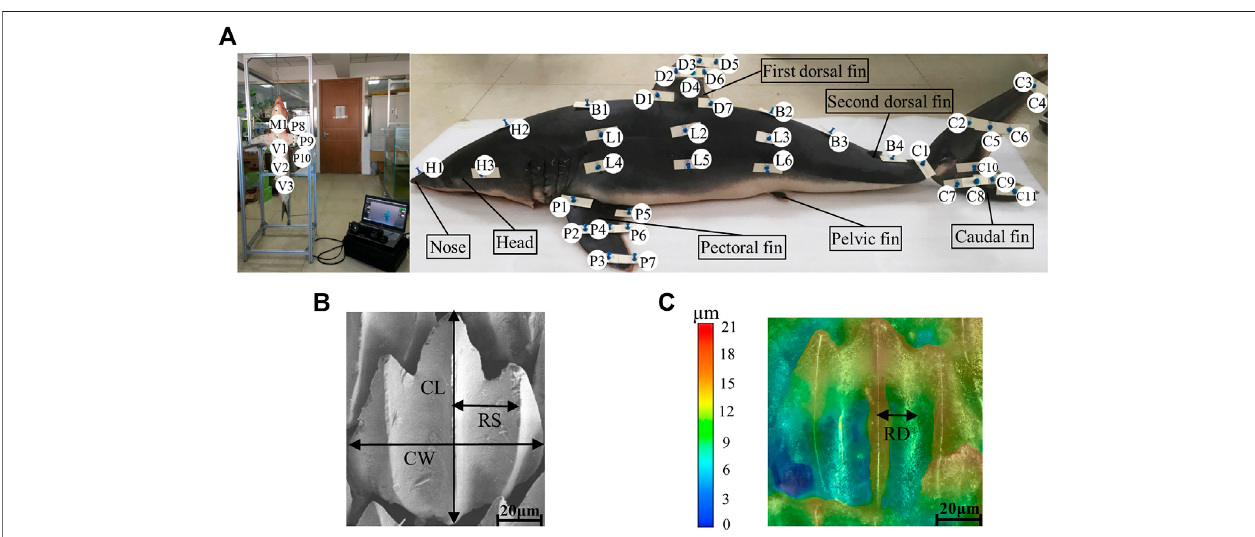
FIGURE 3 | Collection and measurement of short fi n mako shark samples. (A) Locations of collected samples on the short fi n mako shark. Each letter represents a sampling region: H, head; B, back; D, dorsal; C, caudal; L, lateral; P, pectoral; V, ventral; and M, lower jaw. (B) Measurements of crown length and crown width were taken from the medial riblet. Riblet spacing was measured from the groove adjacentto the central riblet. CL, crown length; CW, crown width; and RS, riblet spacing. (C) Riblet depth was measured from the groove adjacent to the central riblet. RD, riblet depth. The color gradient corresponds to riblet